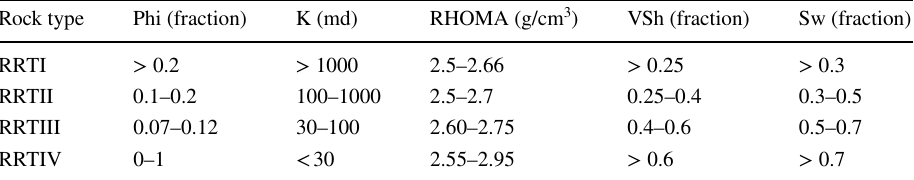
Table 3 Cutoff values for each reservoir rock type (RRT) based on the results retrieved